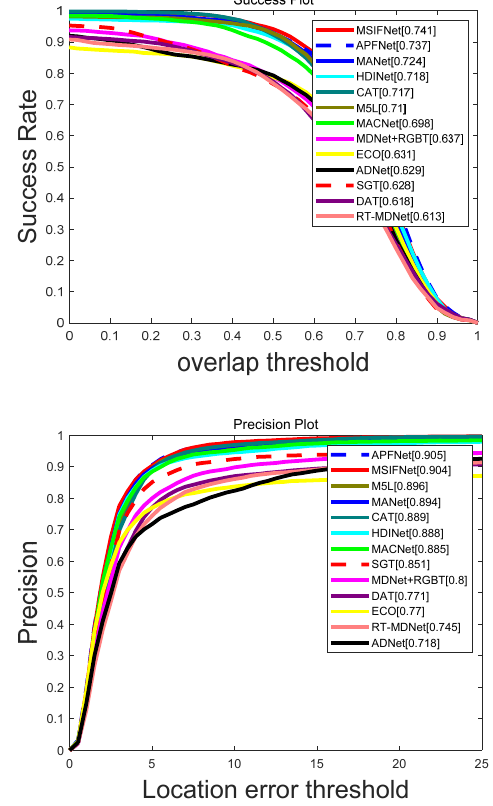
Figure 7. Evaluation curves for PR/SR metrics on GTOT.